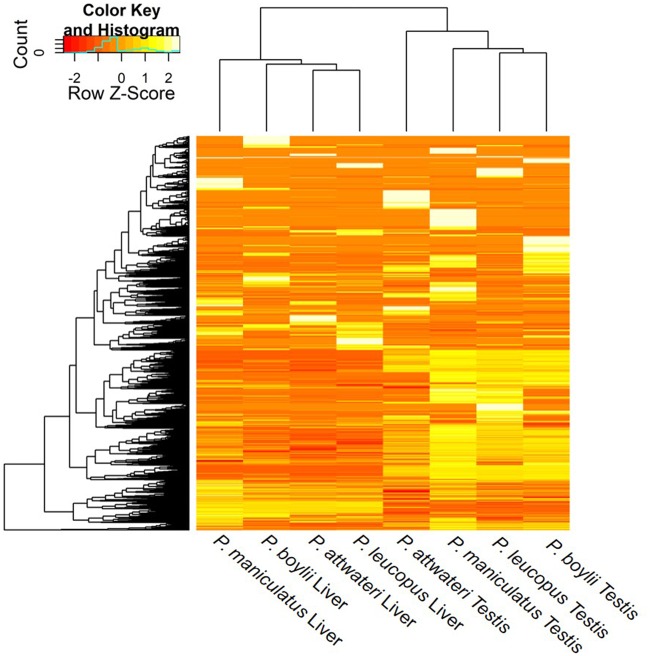
—Constructed heatmap of all liver and testes transcriptomes of Peromyscus generated using a genome-guided assembly. All liver transcriptomes exhibit similar transcript expression patterns, and all testes transcriptomes exhibit similar transcript expression patterns. The darker the color (red) the less expression, the lighter the color (white) the more expression of the gene in the transcriptome.